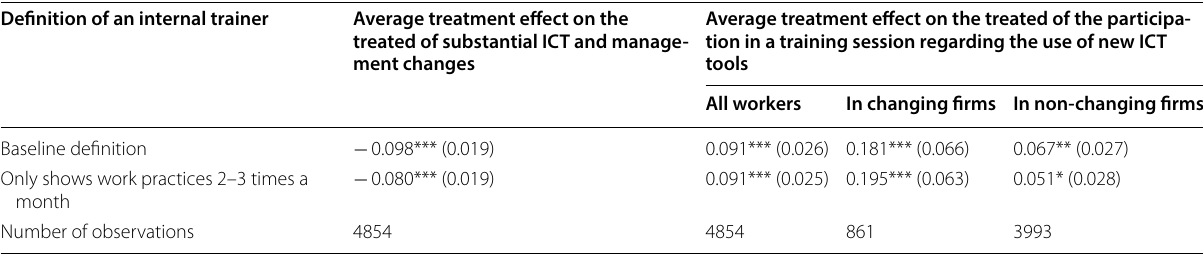
Source: COI survey 2006/INSEE-DARES-CEE Coverage: Workers aged 45–57 years old with at least 1 year of seniority and employed in firms with 20 workers or more In the second column, the treatment is to be employed in a changing firm i.e. a firm that has experienced substantial ICT and management changes. In the other columns, the treatment is the participation in a training session about new ICT tools in 2006. Standard errors (in parentheses) have been estimated using bootstrap procedures with 500 replications. Significance levels are *** p < 0.01, ** p < 0.05 and *p <